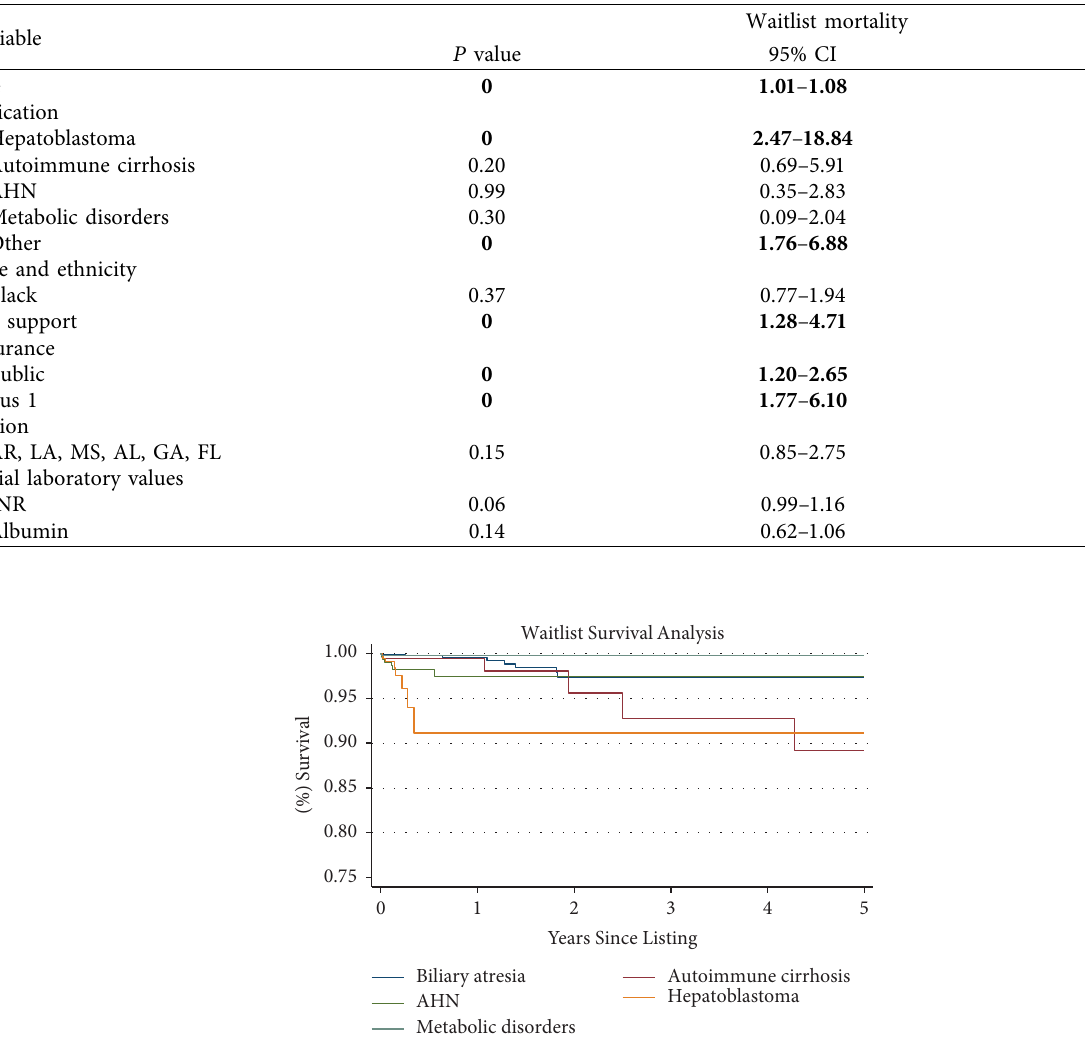
Table 4: Multivariable analysis: waitlist mortality.